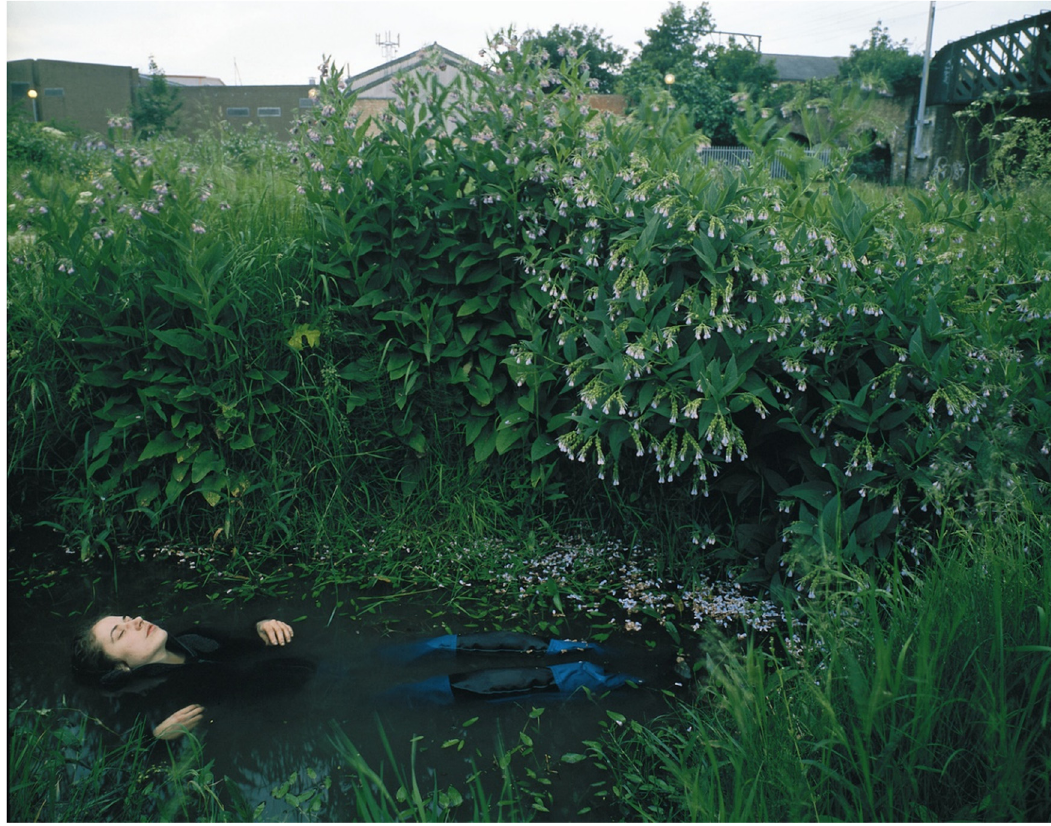
Figure 4: Tom Hunter, “ The Way Home, ” 2000, colour print. https://aad40002josephrichardson. fi les.wordpress.com/2015/02/ tom -